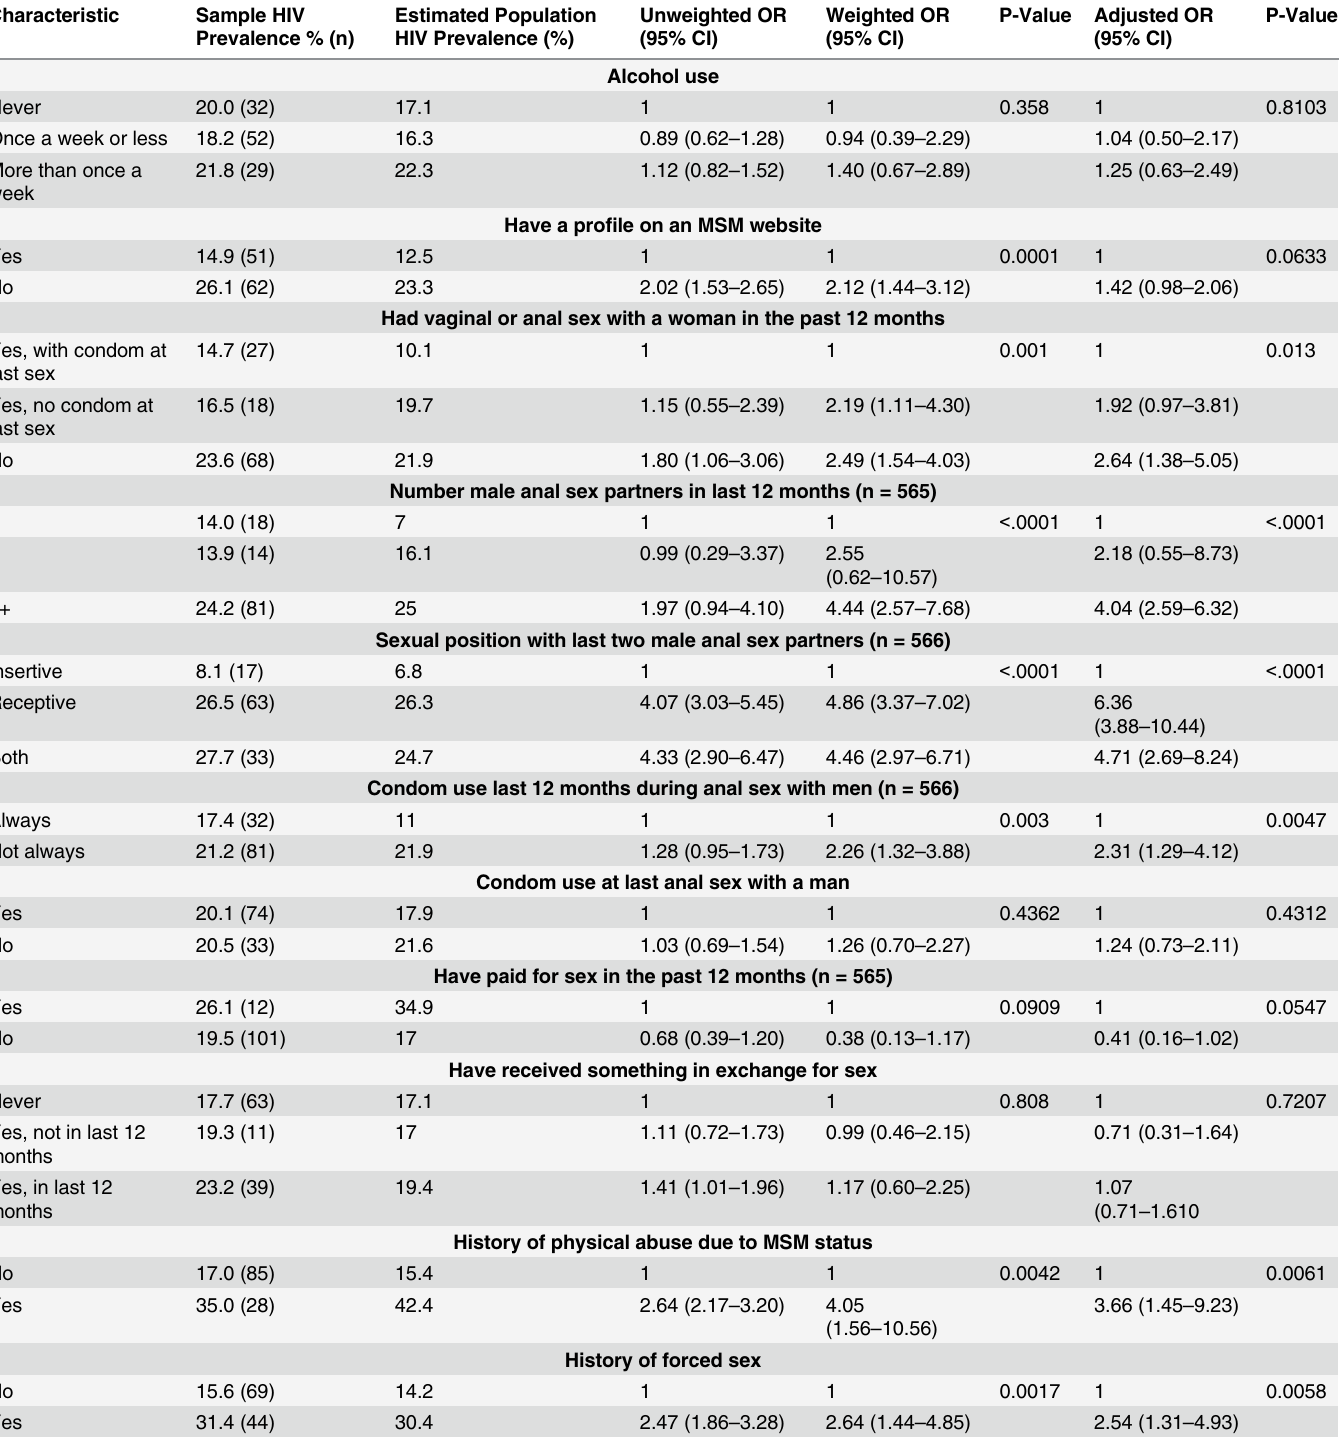
Table 4. Behavioral and Knowledge Correlates of HIV Infection Among MSM in Abidjan, Côte d ’ Ivoire, 2011 – 2012 (n = 581).